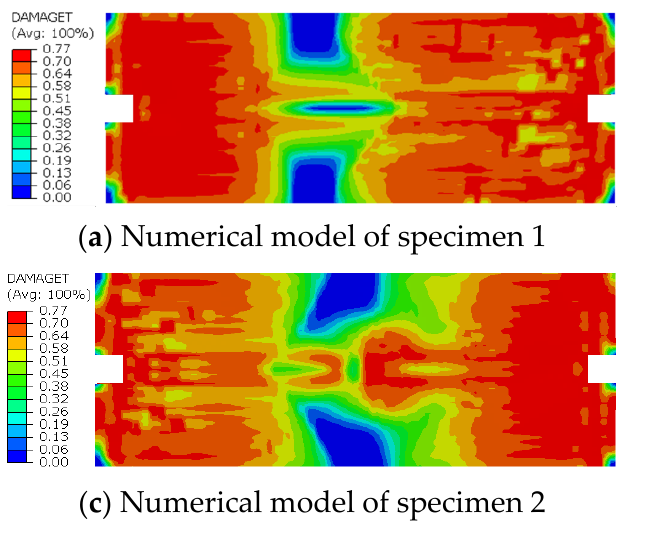
Figure 11. Concrete damage distribution.